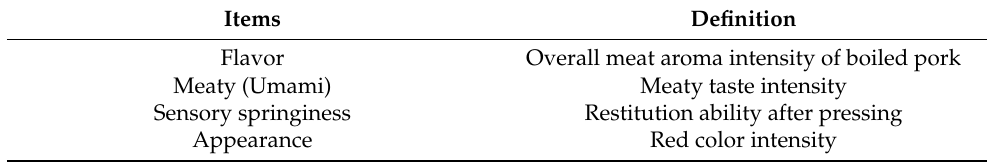
Table 1. The scoring criteria of sensory parameters used in the sensory evaluations of the pork samples.